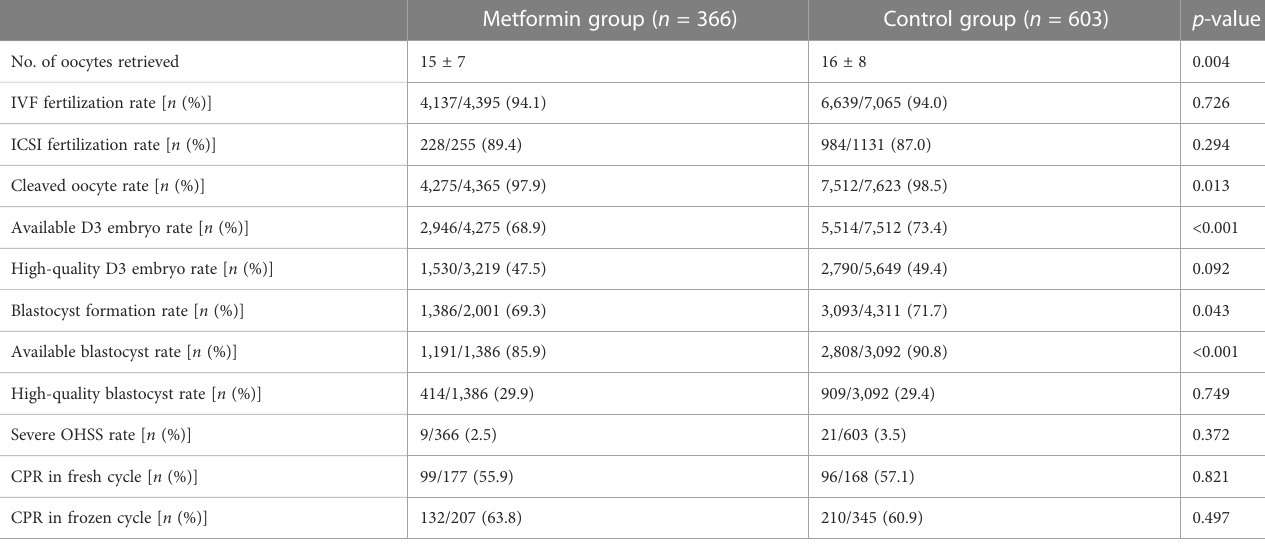
TABLE 2 COS outcomes and clinical pregnancy outcomes between the metformin group and the control group in all PCOS patients. Metformin group ( n = 366) Control group ( n =